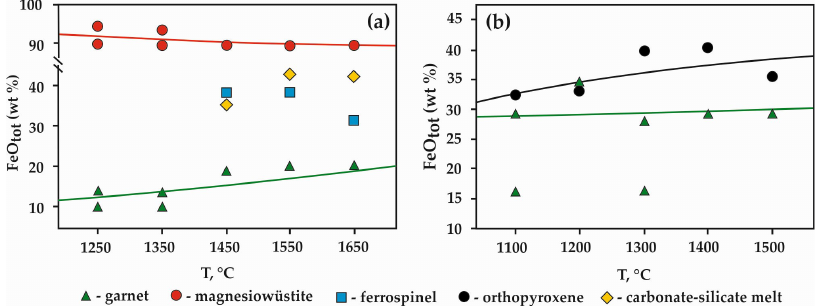
Figure 3. Temperature dependence of FeO content in silicate and oxide phases: ( a ) “sandwich”-type experiments, P = 7.5 GPa; and ( b ) “mixture”-type experiments, P = 6.3 GPa.